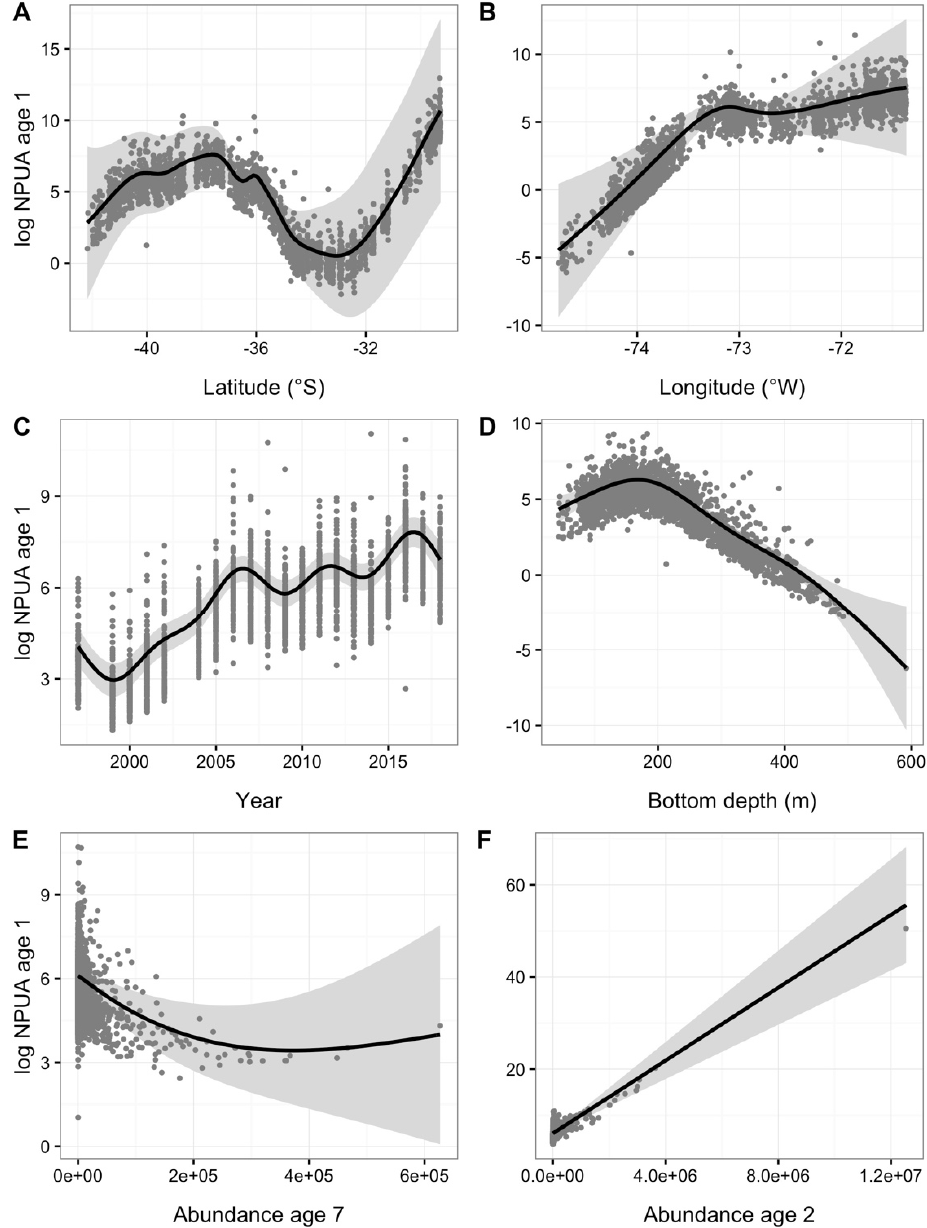
Figure 7. Relationships between the abundance of juvenile Chilean hake of age 1 and relevant variables for spatiotemporal effects of latitude ( A ), longitude ( B ), year ( C ), bottom depth ( D ), and endogenous effects of older adult hake of age 7+ ( E ) and juvenile hake of age-2 ( F ), according to the best model fitted (Model M1.8, Table 2).